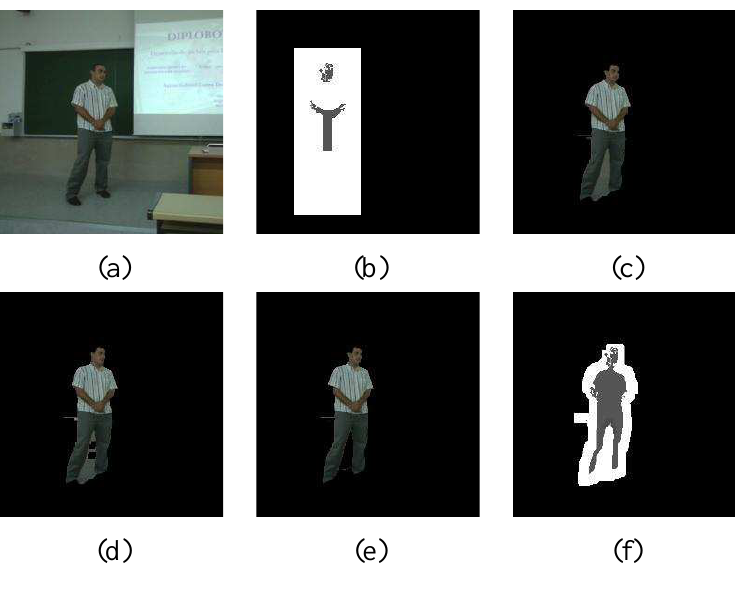
Figure 2. STGrabcut pipeline example: ( a ) Original frame, ( b ) Seed initialization, ( c ) GrabCut, ( d ) Probabilistic re-assignment, ( e ) Refinement and ( f ) Initialization mask for f t +1